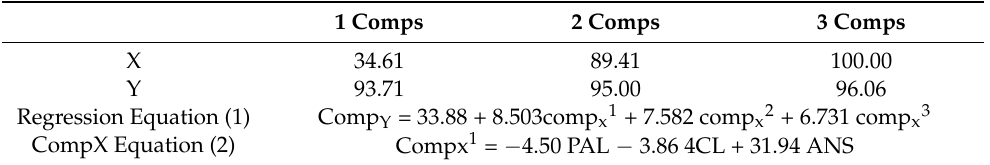
Figure 7. Seed morphological characteristics of different varieties of Tartary buckwheat. ( A ) Seed images under a microscopic imaging system, ( B ) seed X-ray images under an X-ray digital imaging system, and ( C ) grayscale brightness value. Note: Chuanqiao No. 1 VS. Chuanqiao No. 2, Xiqiao No. 2, Miqiao No. 1, and Di Ku, a p < 0.05; Xiqiao No. 1 VS. Chuanqiao No. 2, Xiqiao No. 2, Miqiao No. 1 and Di ku, b p < 0.05. Table 3. PLS regression model of effects of flavonoid key enzyme gene expression on the seed coat color of Tartary